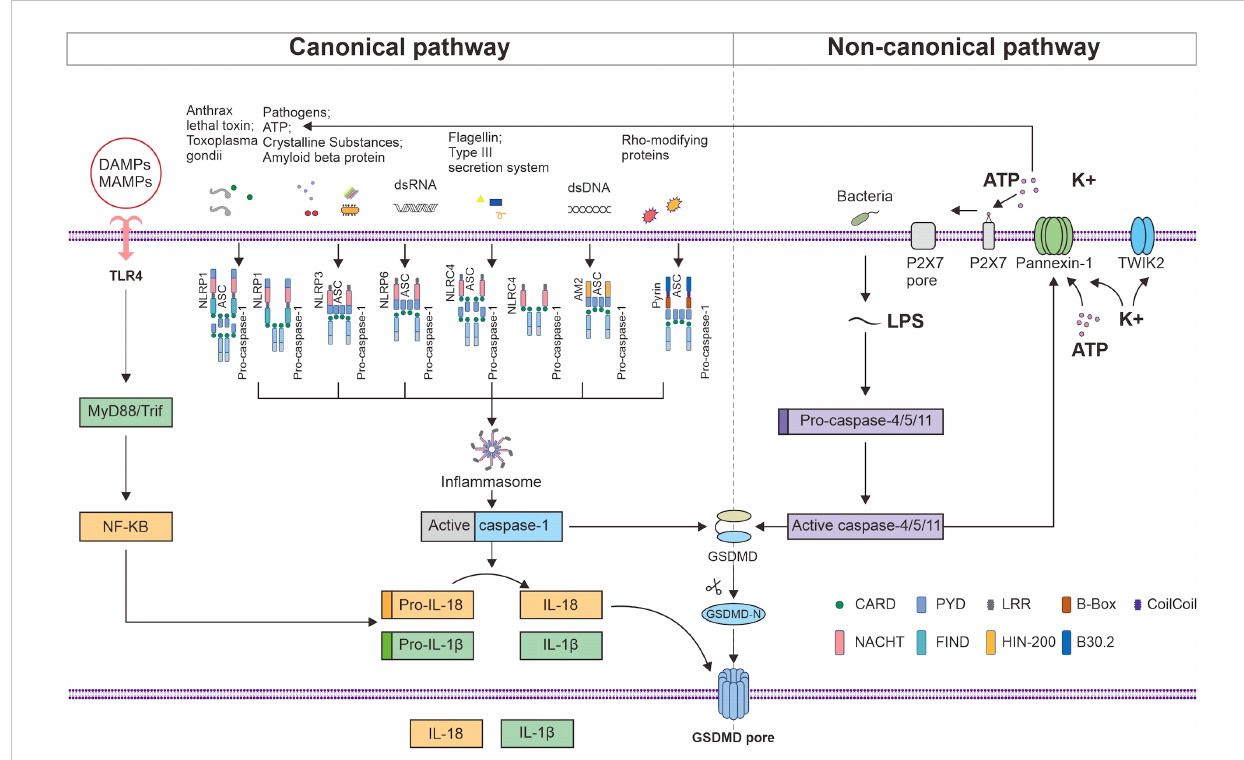
FIGURE 1 NLRP1, NLRP3, NLRP6, NLRC4, AIM2, and Pyrin can recruit procaspase-1 in an ASC-dependent manner, whereas NLRP1 and NLRC4 may also recruit procaspase-1 to the complex via CARD – CARD interactions. MAMPs and DAMPs are detected by TLR4, which induces the MyD88/NF- k B signaling pathway to produce pro-IL-1 b and pro-IL-18. Activated caspase-1 promotes the maturation and secretion of IL-1 b and IL-18 and cleaves GSDMD. The released active N-terminal domain of GSDMD causes membrane perforation and the release of the cell contents. LPS initiates pyroptosis via the noncanonical route by activating mouse caspase-4 and 5 or human caspase-11 to cleave GSDMD. The activated caspase-4, 5, and 11 cleave pannexin-1 and induce the release of ATP and K + , thereby activating the NLRP3 in fl ammasome. The ef fl ux of K + and ATP also activates P2X7, which forms a P2X7 pore in the cell membrane, promoting Ca 2+ and Na + in fl ux. TWIK2 mediates K + ef fl ux in coordination with P2X7 and thus initiates P2x7-related pyroptotic cell